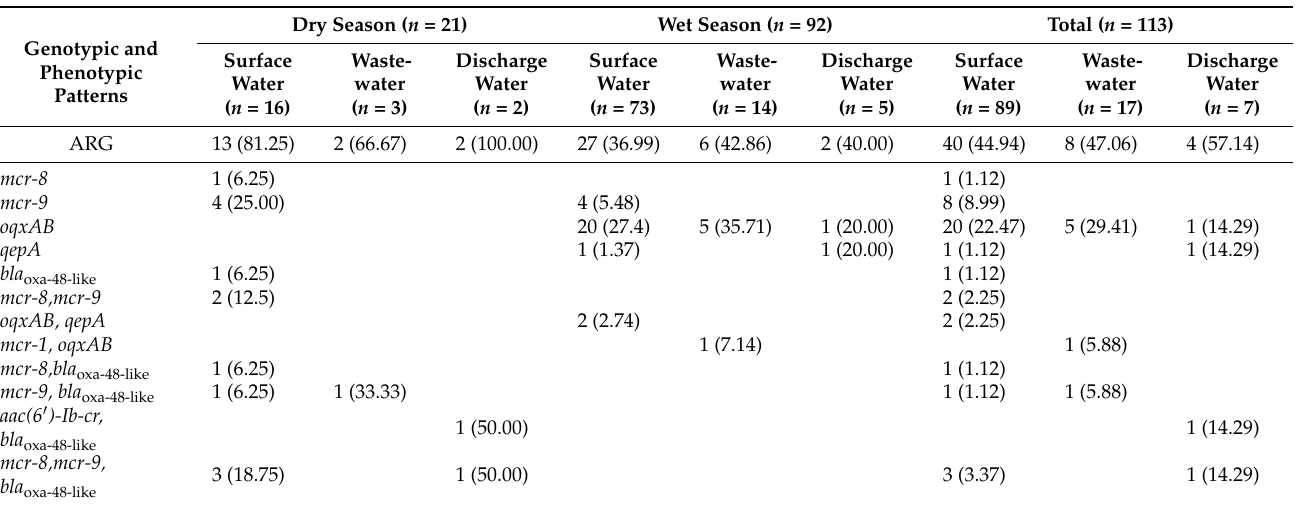
Table 2. Prevalence of the genotypic and phenotypic patterns of the E. coli isolates from each water source during the dry and wet